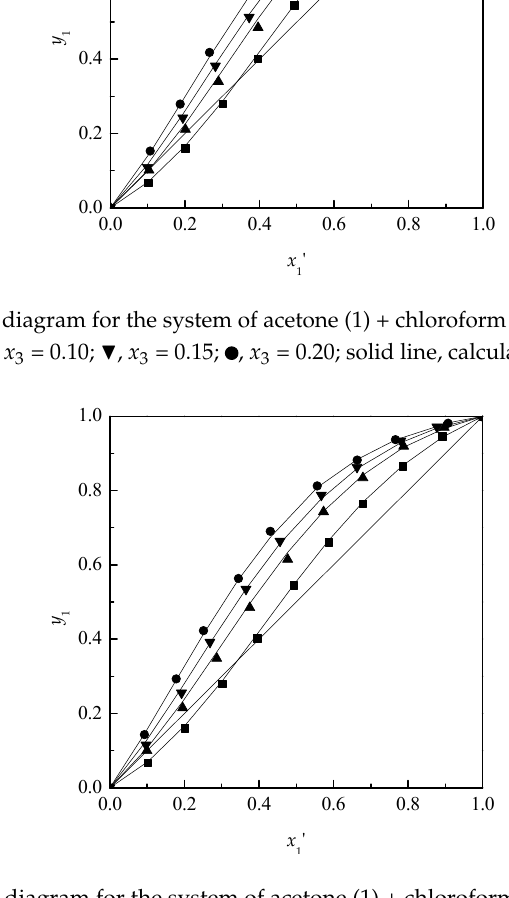
Figure 4. Relative volatility of acetone (1) + chloroform (2) containing [MIM][DMP] or [EMIM][DEP] (3) at 101.32kPa. x([MMIM][DMP]), %: ■ 0; ▲ 10; ▼ 15; ● 20; x([EMIM][DEP]), %: ■ 0; △ 10; ▽ 15; ○ 20; Solid line, calculated using NRTL model.